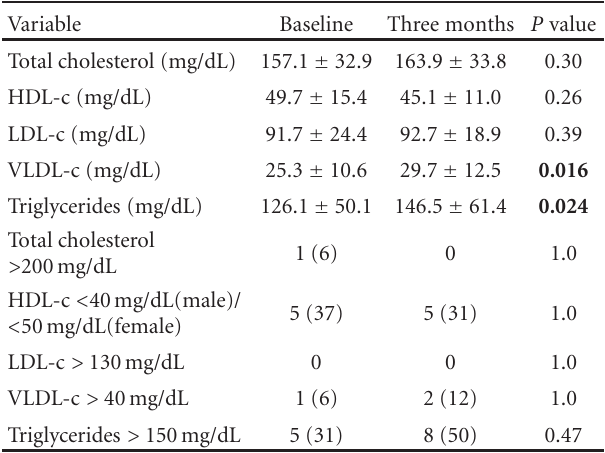
Table 2: Lipid profile at baseline and at three months after starting anti-TNF therapy in psoriatic arthritis